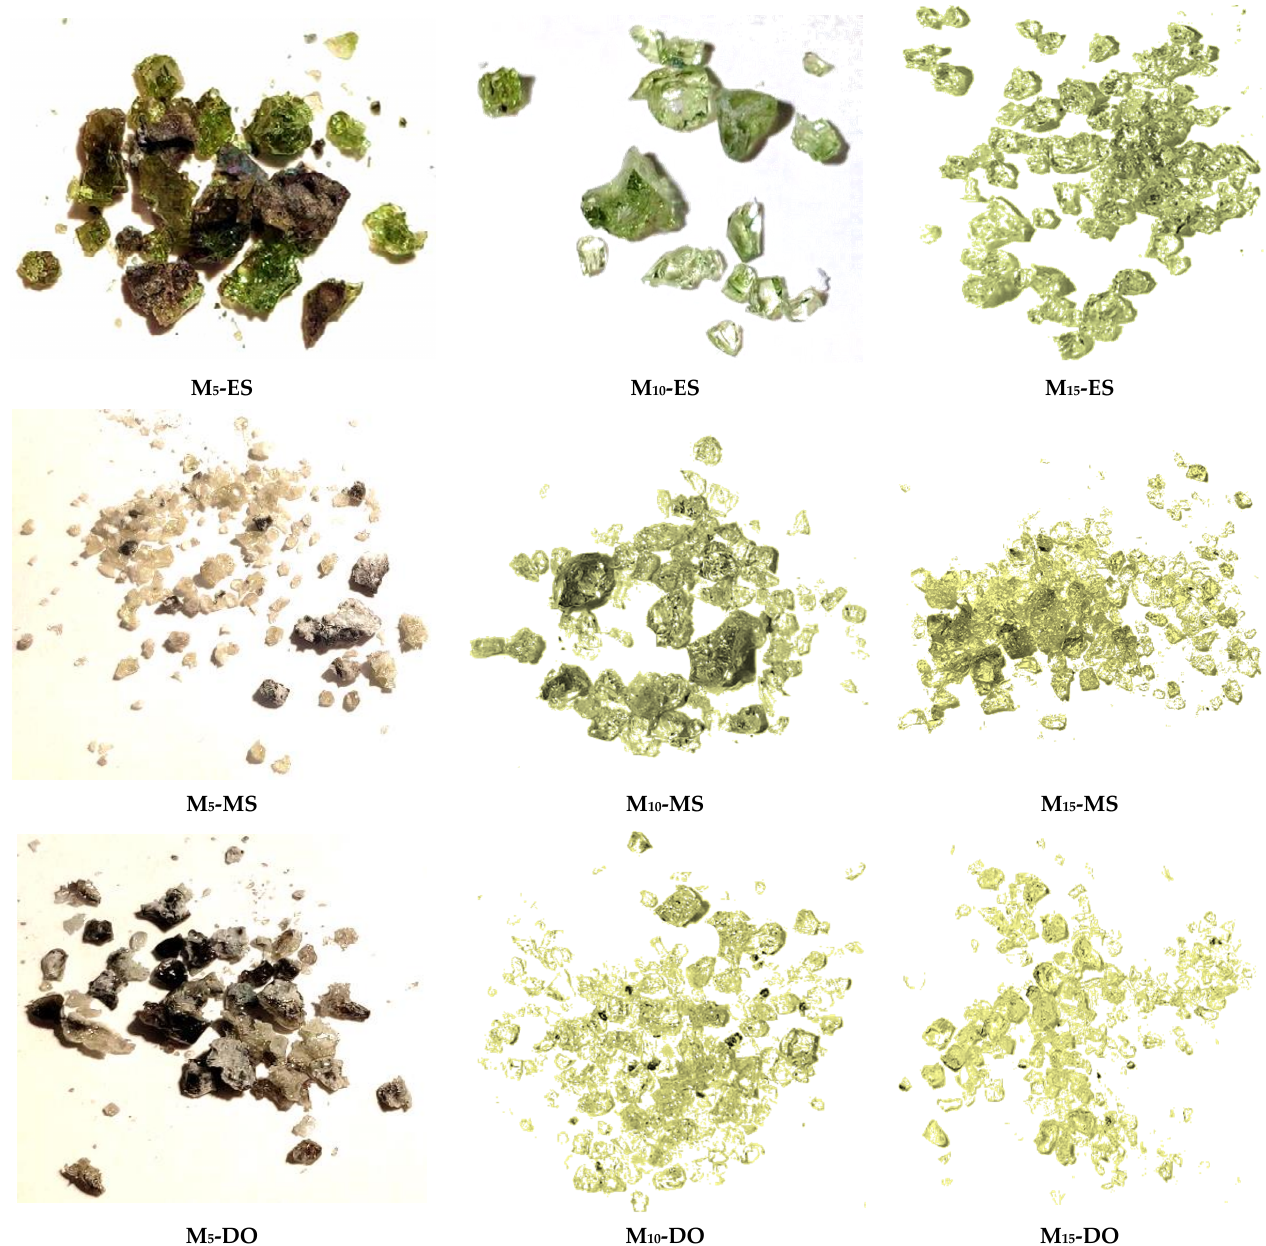
Figure 6. Macroscopic appearance of the frits obtained by CSE.